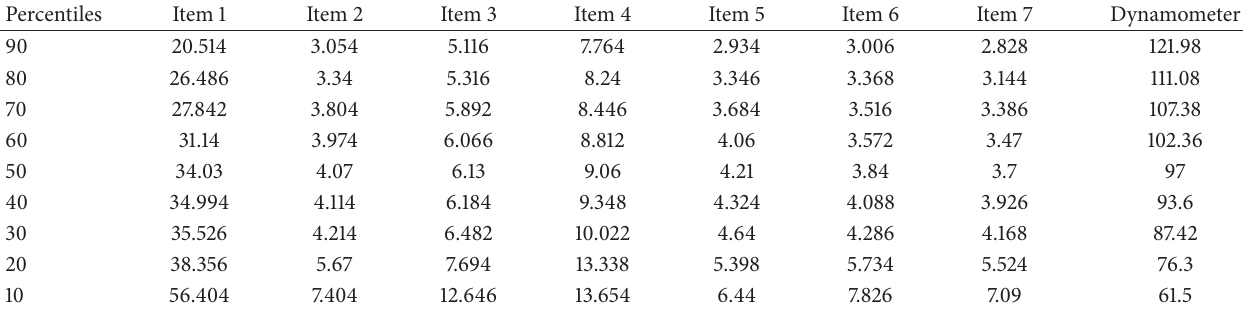
Table 14: 𝑛 = 17 , males, 20–94, nondominant hand, educational instruction: degree.